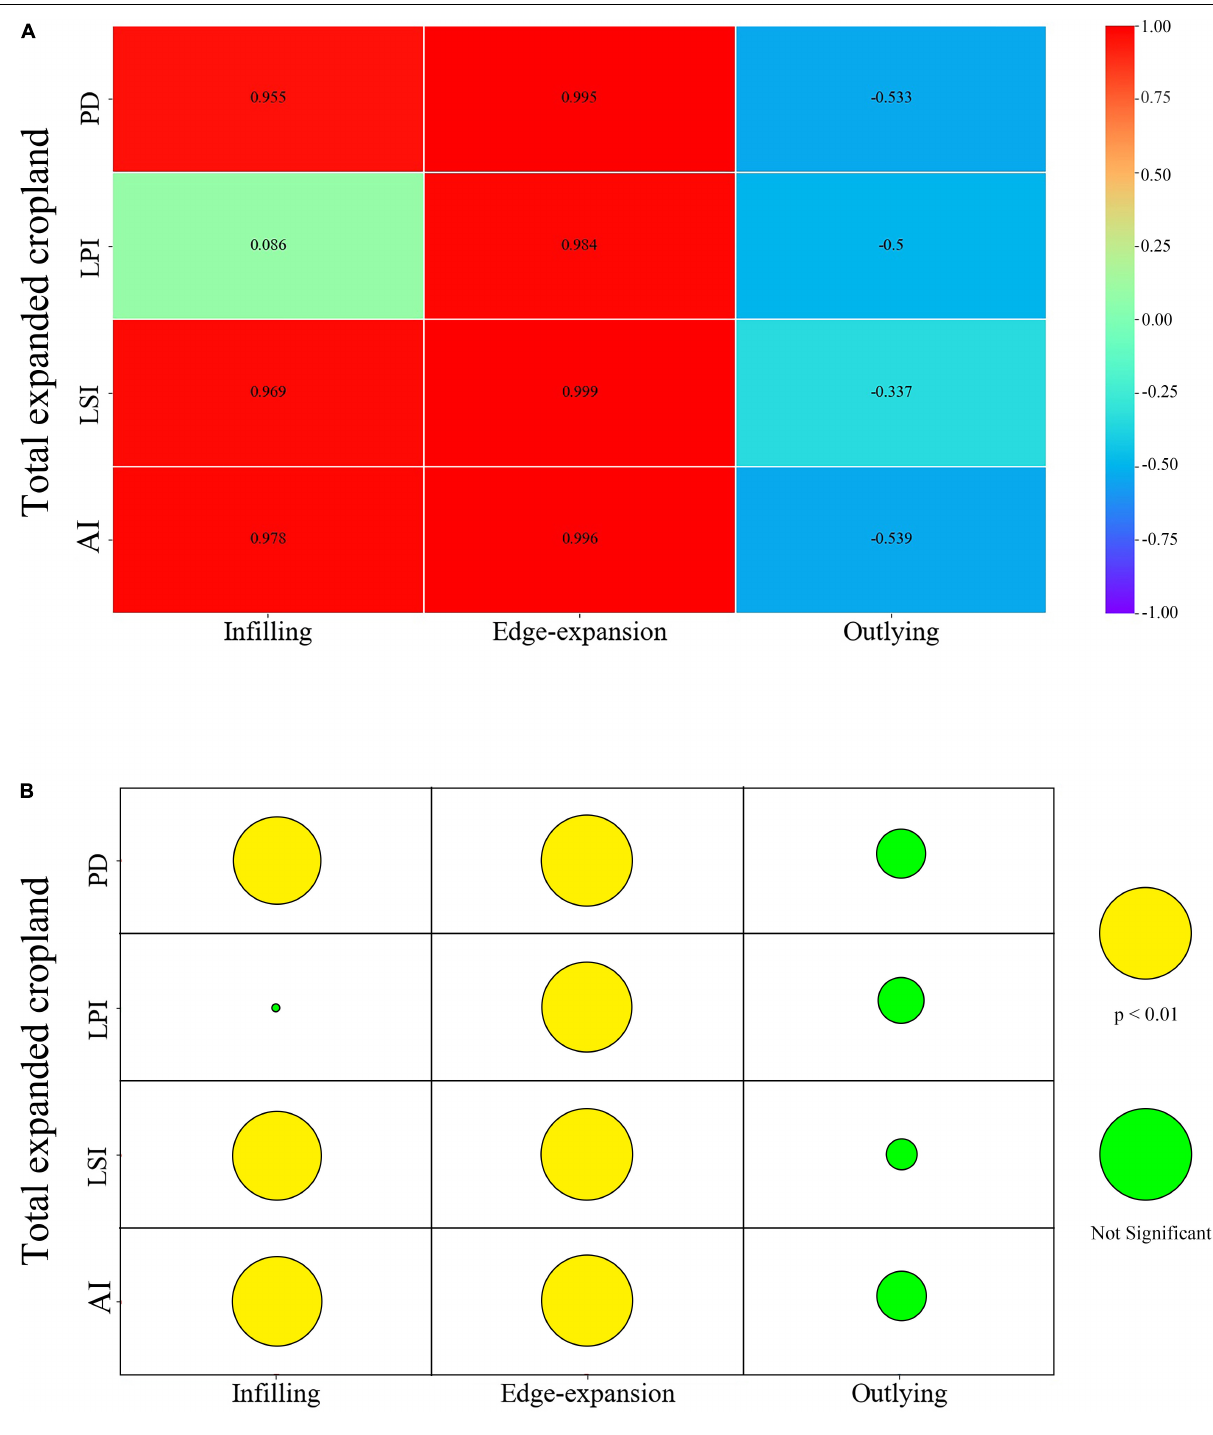
with urban expansion modes: edge-expansion trajectory is primary over research areas and periods, and the decreasing sequence of cropland expansion trajectories is infilling trajectory